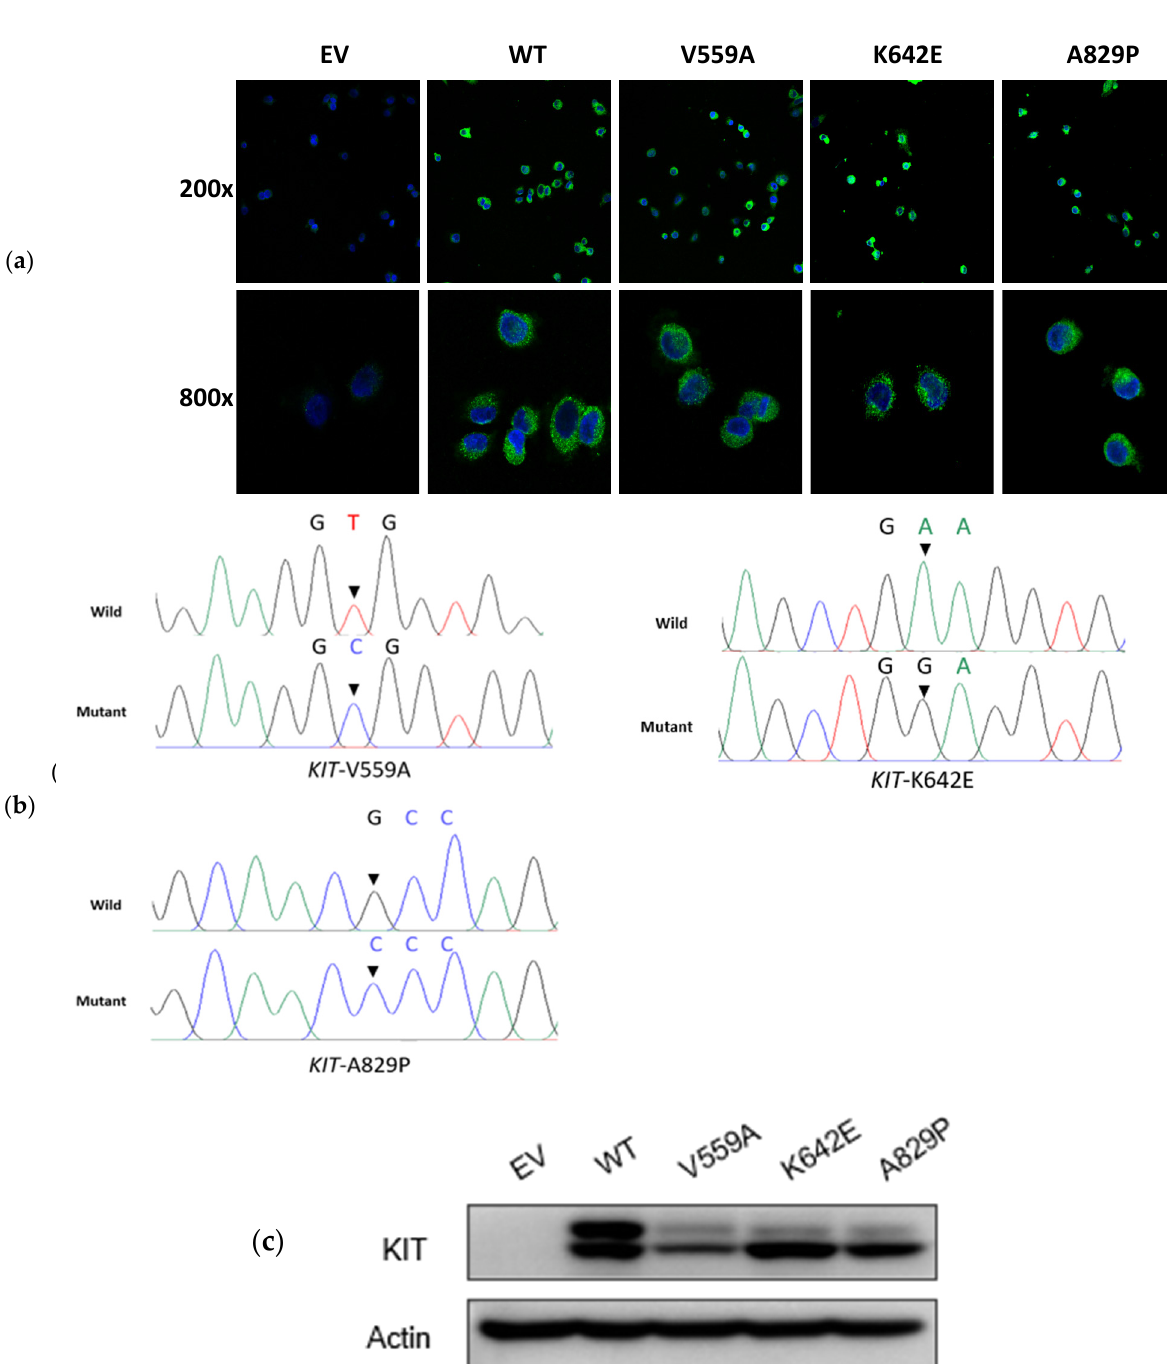
Figure 4. The successful construction of wild/mutant KIT overexpressed cells. ( a ) Immunocytochem- istry images showing the expression of KIT (green; nuclei: blue) in 293T cells. ( b ) Sanger sequencing identified that mutant KIT had been successfully constructed and transfected into 293T cells. The total RNA was extracted from transfected cells, and reverse transcriptions were subsequently conducted. PCR experiments were used for amplifying targeted sequences. ( c ) Western blotting identified that the wild/mutant KIT proteins were successfully expressed in stably transfected 293T